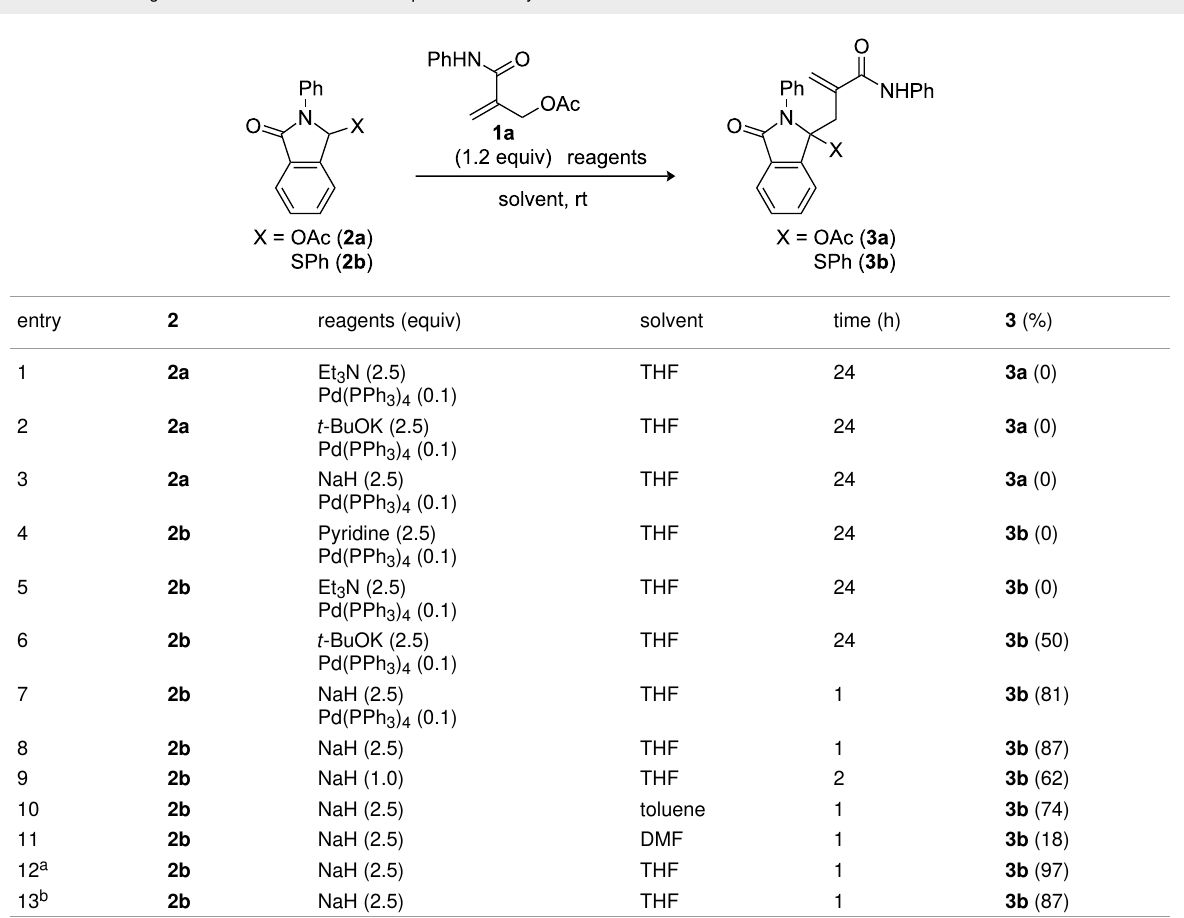
Table 1: Screening of reaction conditions for electrophilic amide